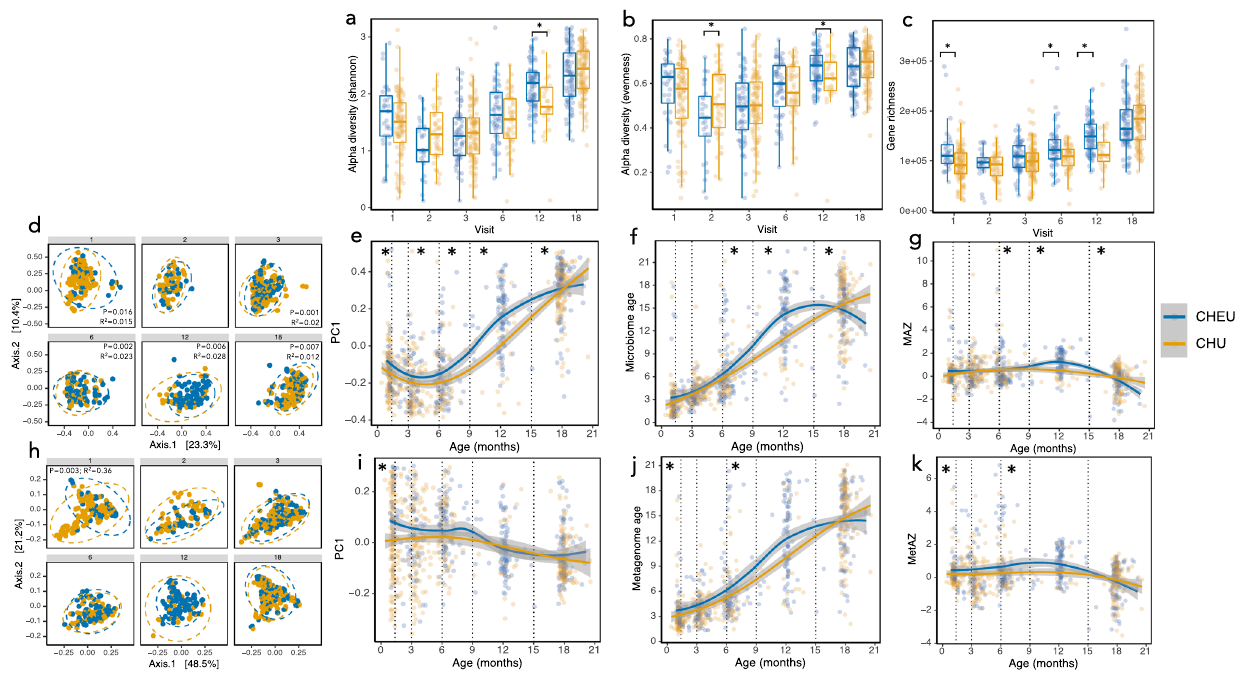
Fig. 3 | Maternal HIV infection comprehensively alters infant gut microbiome diversityandmaturity. Shannonalphadiversity( a ),speciesrichness( b )andgene richness ( c ) shows signi fi cant over-diversi fi cation in CHEU vs CHU (multivariate regression, two-sided * p <0.05; the band indicates the median, the box indicates the fi rst and third quartiles and the whiskers indicate±1.5 × interquartile range). PCoA of Bray-Curtis distances ( d ) and PC1 ( e ) of species composition in CHEU vs CHUshowsigni fi cantdifferencesthroughout18monthsof life(PERMANOVA;two- sided p -value; dotted lines represent 95% con fi dence ellipses). Microbiome age ( f ) and microbiome-for-age Z score (MAZ; g ) shows signi fi cant differences in gut